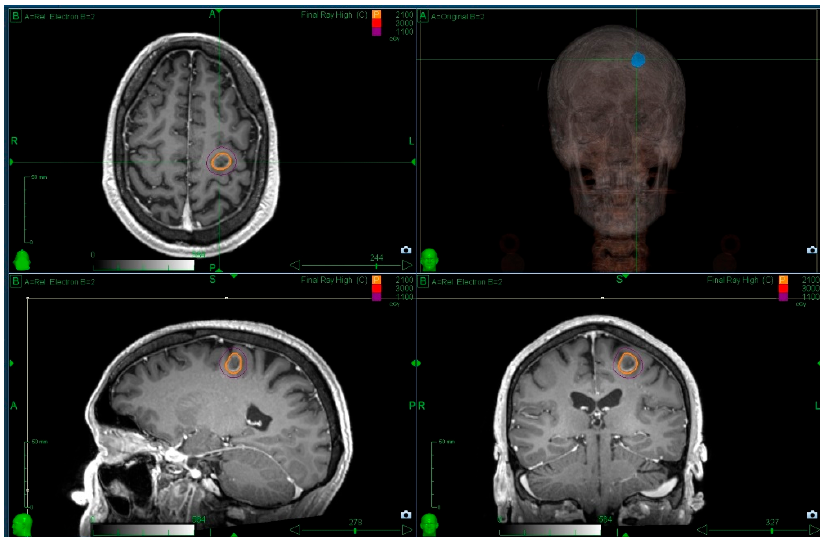
Figure 1. Radiosurgery for patients with a single metastasis and a favourable prognosis is standard practice. The figure illustrates a single metastasis covered with a prescription dose of 21 Gy prescribed to the 70% isodose line using Cyberknife. Prior informed consent was obtained for use of these images.